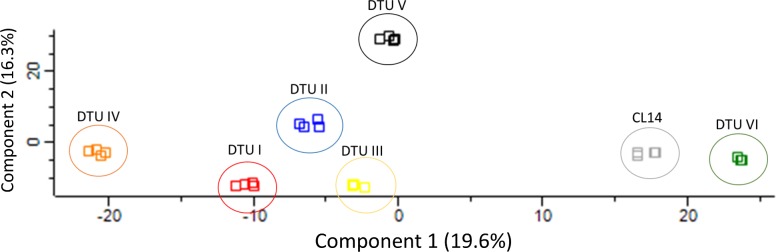
Principal component analysis of seven T.cruzi strains belonging to six DTUs based on differentially regulated proteins.LC-MS/MS data acquired for Sylvio X10 cl1 (DTU-I), Y (DTU-II), M6241 cl6 (DTU-III), CanIII cl1 (DTU-IV), MN cl2 (DTU-V), CL14 and CL Brener (DTU-VI) strains were searched against Uniprot T. cruzi Protein Database (release July 11, 2017; 51,738 entries) using MaxQuant computational platform as described in step C of Fig 1. Quantified proteins were analysed by ANOVA with Benjamin-Hochberg correction. 1096 differentially expressed proteins (qvalue<0.05) were used to perform the principal component analysis (PCA). DTU I—Red, DTU II—Blue, DTU III—Yellow, DTU IV—Orange, DTU V–Black, CLBrener–Green and CL14—Grey. All DTUs were separated and two strains belonging to DTU-VI (CL Brener and CL14) clustered together.